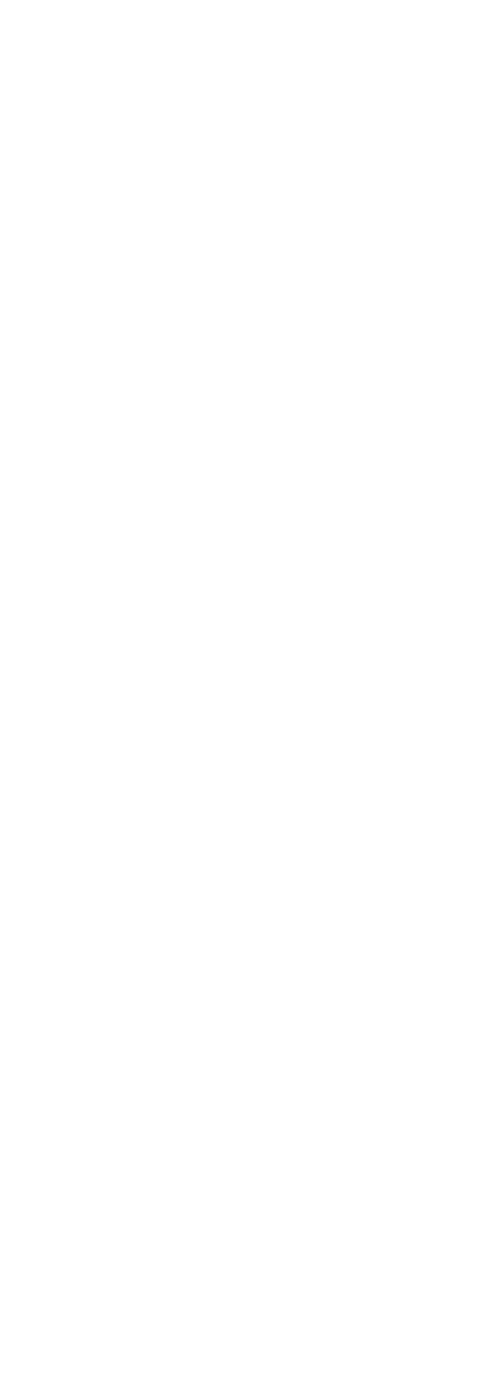
Fig. 4. Schedule of Ho Chi Minh city school in